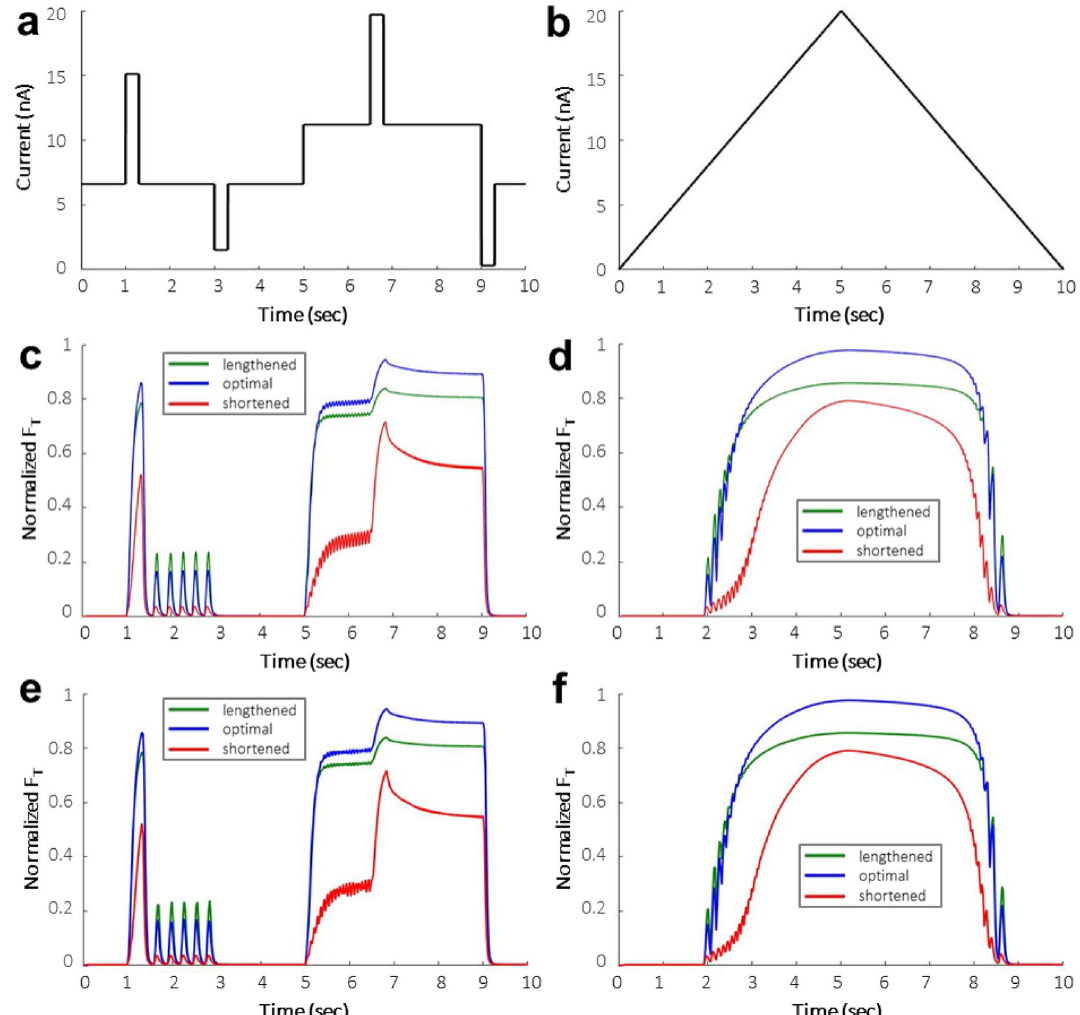
Figure 1. ( a , b ) Input activation profiles from Kim 19 implemented in the single neuron NMS model to show software integration. ( c , d ) Neuromuscular muscle force results from Kim 19 (Figs. 3B, 4B), reproduced here using publicly available data from ModelDB 32 . ( e , f ): Muscle force outputs from FE NMS simulations at lengthened, optimal, and shortened muscle